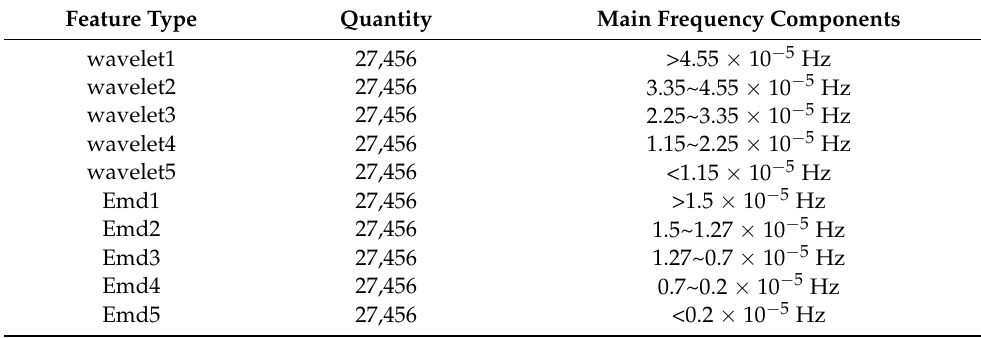
Table 3. Frequency ranges of wavelet and empirical mode decomposition (EMD)